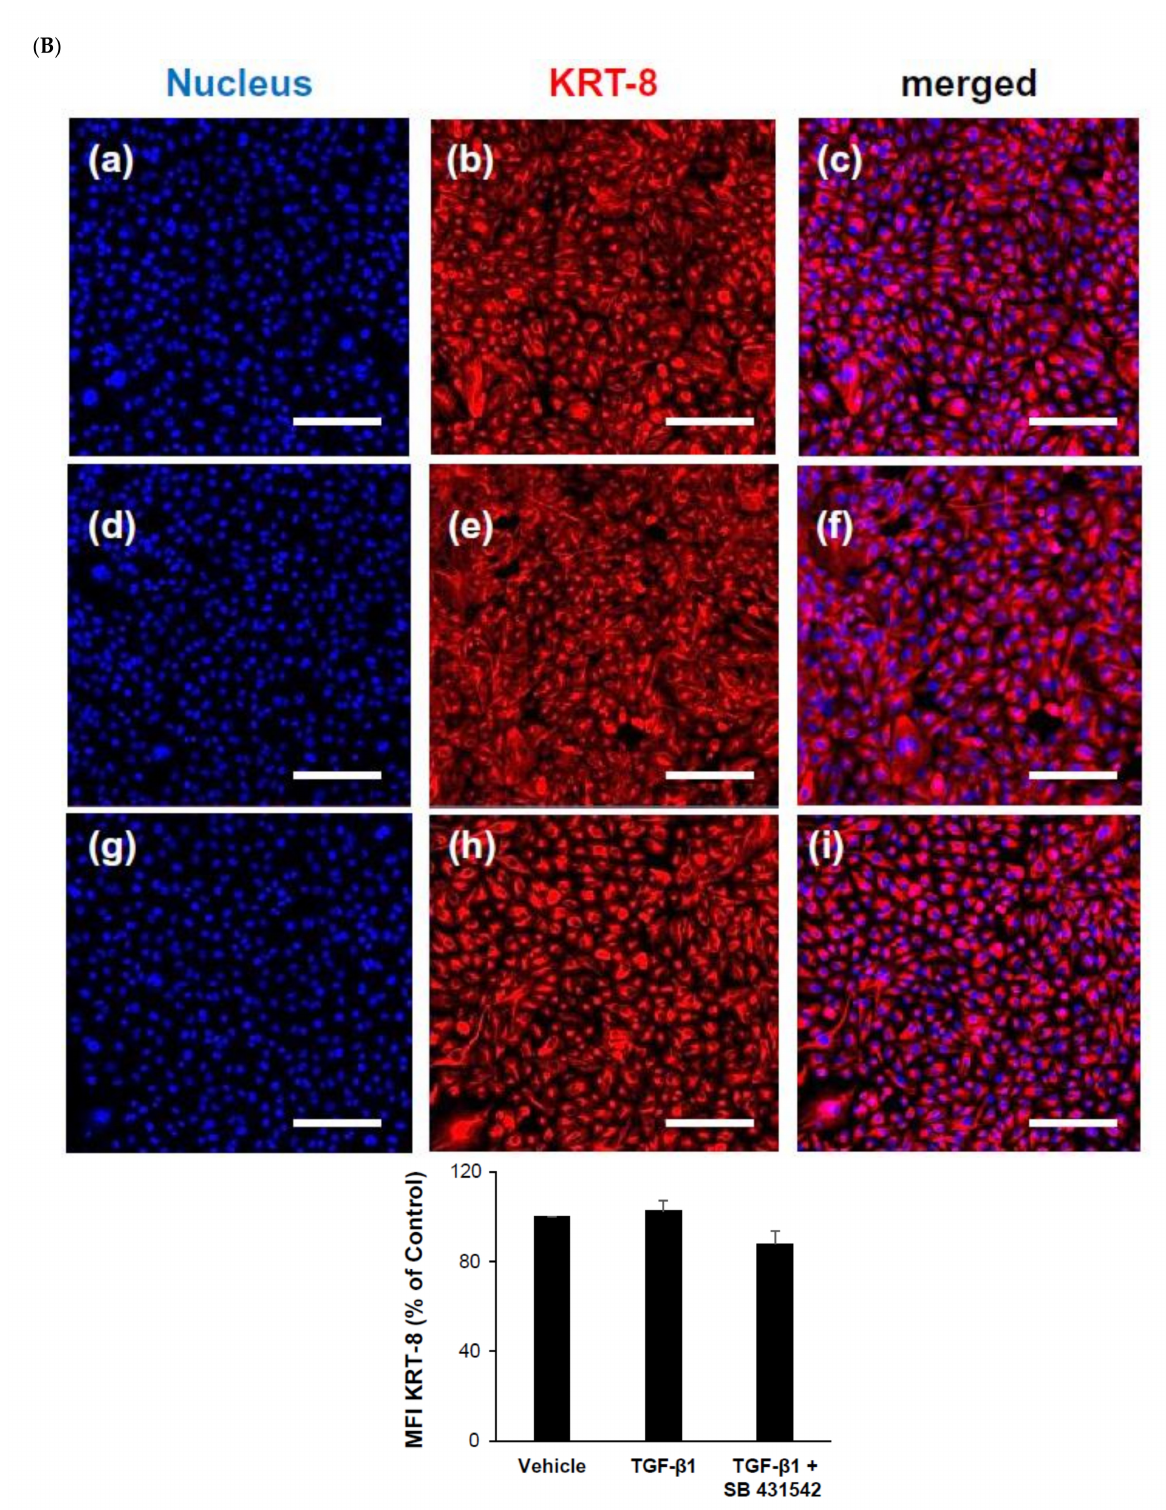
Figure 1. Immunofluorescence shows that the expression of alpha-SMA and keratin-8 (KRT8) were maintained by treatment of TGF- β 1 or the inhibitor in HK-2 cells. ( A ) The expression of alpha-SMA and ( B ) CCK-8 had no effect on HK-2 cells by TGF- β 1 (5 ng/mL) or the inhibitor. Cells were originally plated at a density of 1 × 10 5 per well ( a–c ) untreated control and ( d–f ) stimulated with 5 ng/mL TGF- β 1 or ( g–i ) 10 µ M inhibitor (SB 431542) for 24 h and fixated with 4% paraformaldehyde. The cells were then stained with anti- α -SMA and anti-cytokeratin-8 for 20 min. Co-staining with Hoechst dye H33342 to identify cell nuclei was performed. Scale bars in micrographs indicate 200 µ